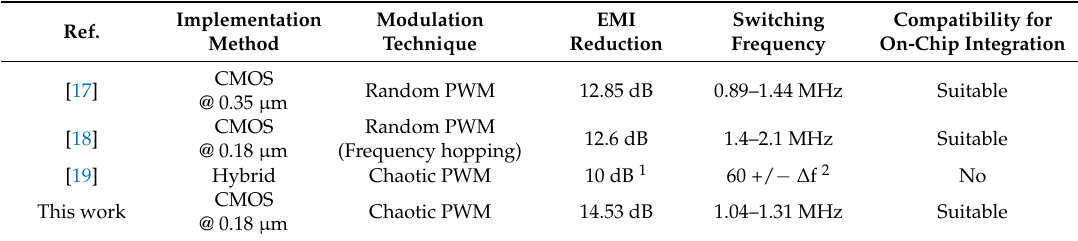
Table 3. EMI reduction performance of the proposed scheme and stage-of-the-art alternatives.